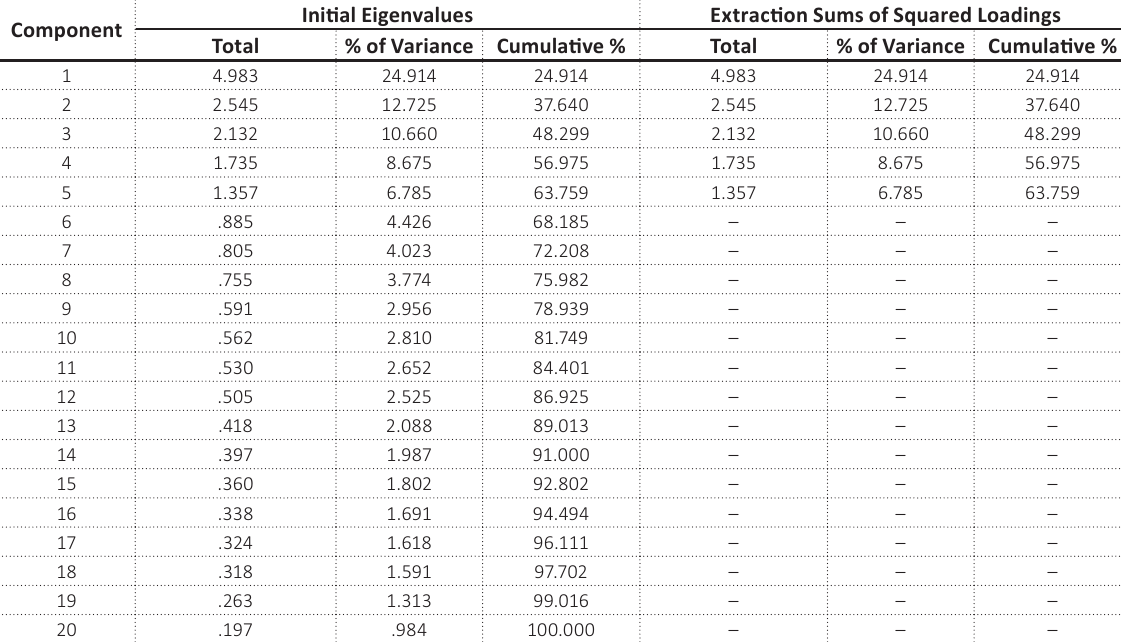
Table 9. Total variance explained by extracted factors Initial Eigenvalues Extraction Sums of Squared Loadings Component